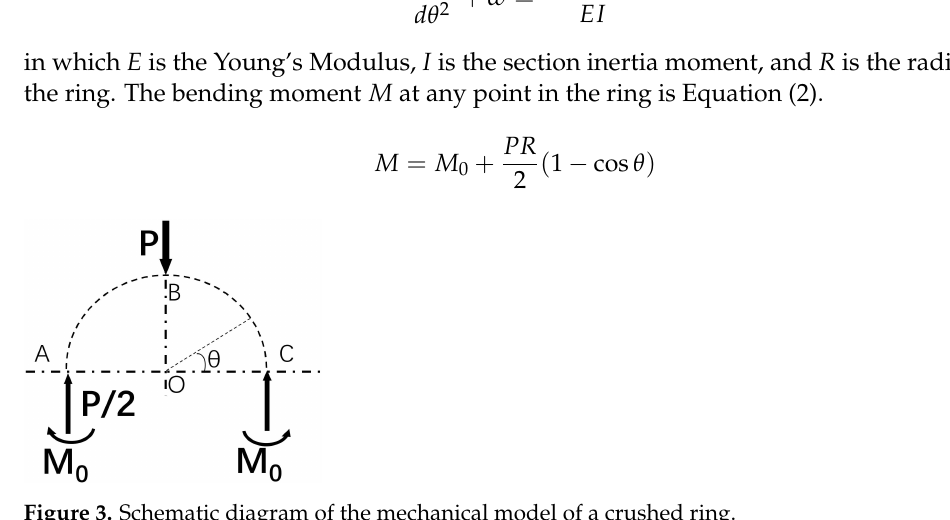
Figure 3. Schematic diagram of the mechanical model of a crushed